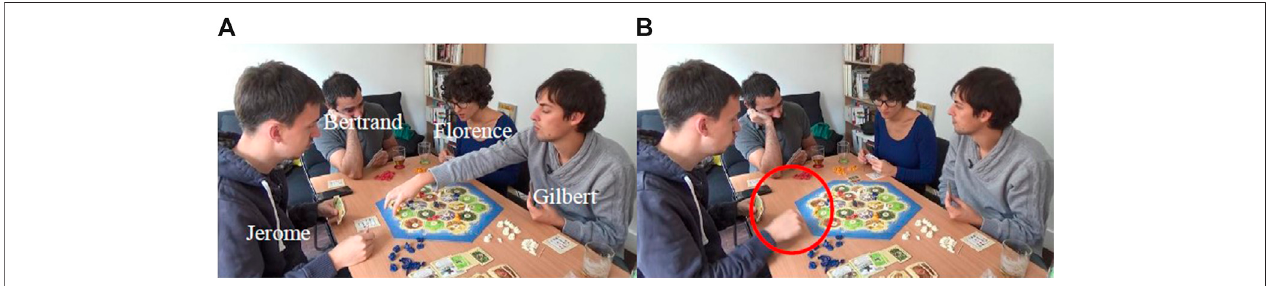
FIGURE 3 | Frames from Extract (5). (A) Gilbert gestures to the place on the board where Florence would build a port (line 4). (B) Jerome gestures a ‘ distance of two ’ outside of the board (line 5).